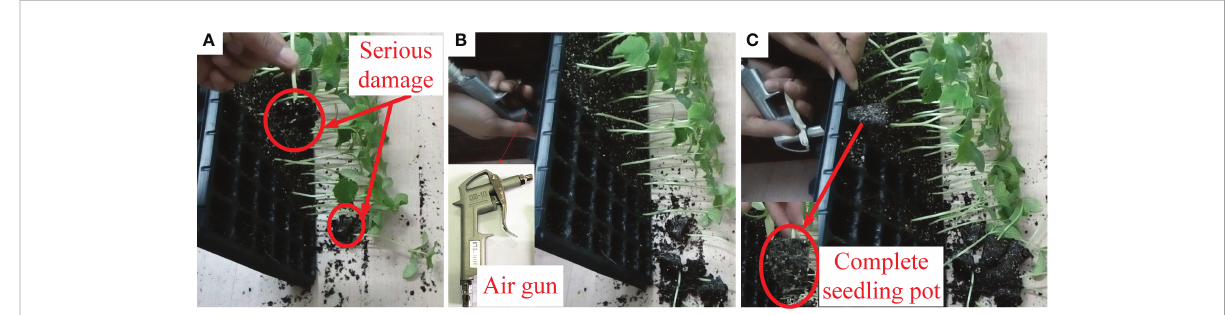
FIGURE 1 The extraction of the overgrown cucumber seedlings. (A) Seedlings seriously damaged after pulling out (B) Overgrown cucumber seedlings, these seedlings encountered continuous overcast and rainy days during cultivation, so the stem of these seedlings was long and thin, with a height of more than 200 mm. The roots of these seedlings were short and weak which could not effectively wind and wrap the substrate, so the substrate was loose and easily damaged, which led to a poor mechanical property of the seedling pots, and these seedlings could not be picked out by the conventional seedling picking methods (C) Seedlings remain complete after air fl ow